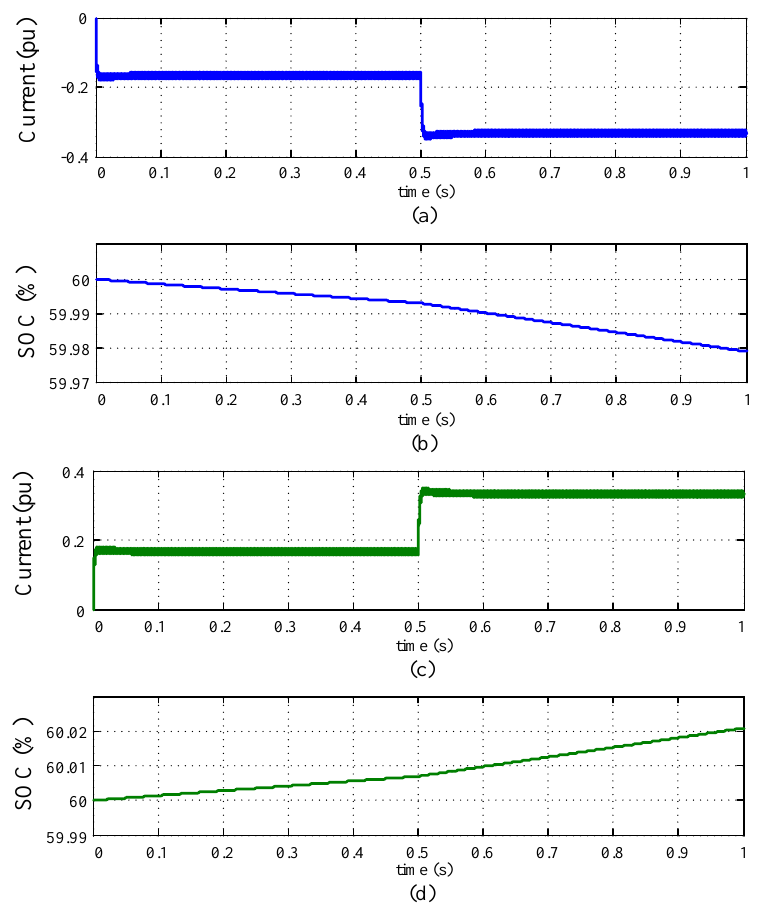
Figure 5. Simulation results of the energy storage system: ( a ) Battery discharge current; ( b ) Battery SOC in case of discharge; ( c ) Battery charge current; ( d ) Battery SOC in case of charge.